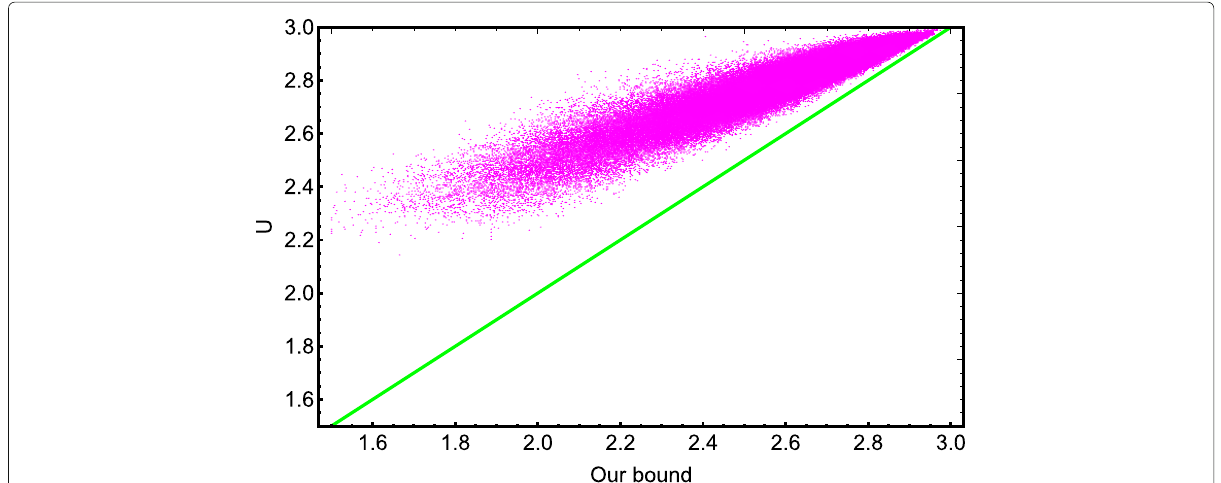
Fig. 3 Uncertainty and our derived bound in regard to 1.5 10 5 four-qubit random states. X-axis represents the lower bound proposed by us and Y-axis represents the uncertainty, respectively. Green line stands for the proportion function with the unitary